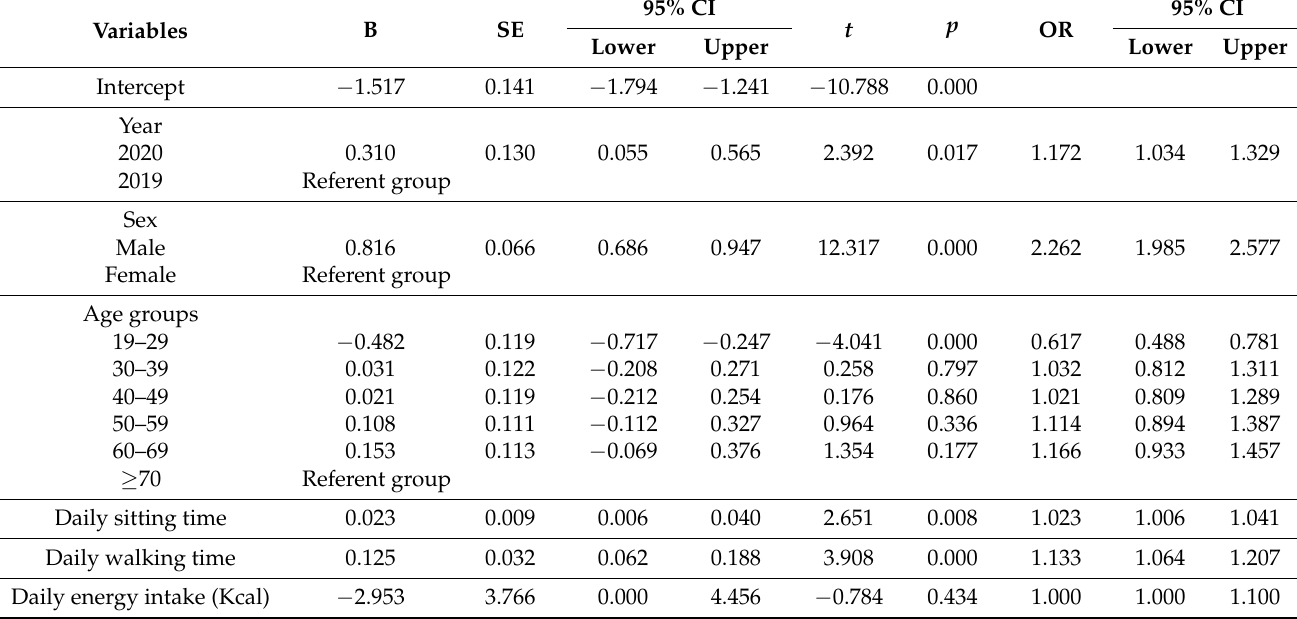
Table 3. Logistic regression analysis on obesity in Korean adults aged 19 and older.